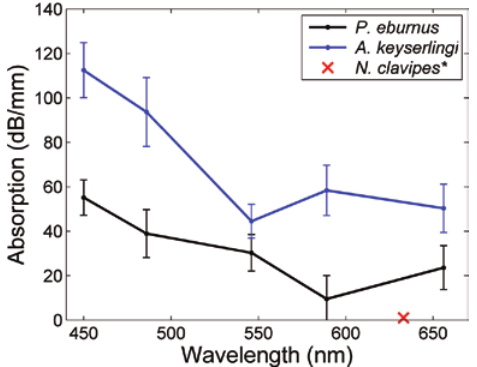
Figure 4: Estimated optical absorption of the Plebs eburnus dragline silk (black curve) and the Argiope keyserlingi dragline silk (blue curve), assuming no transverse optical structure. Absorption of Nephila clavipes dragline silk (red cross) measured by Huby et al. is shown for comparison [5]. The large disparity between estimates and independently measured values is strong evidence for the exist- ence of transverse optical structure within the spider